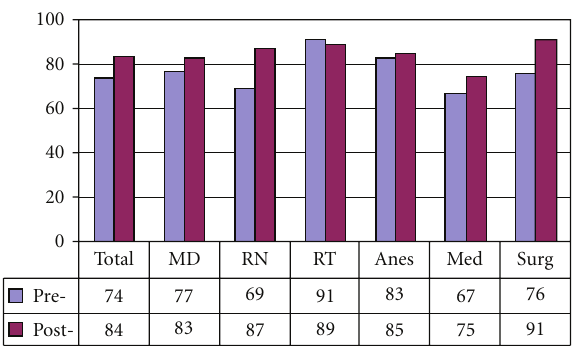
Figure 5: Tracheotomy patients can have an oral airway if tube is cu ffl ess or cu ff is deflated (% Correct).